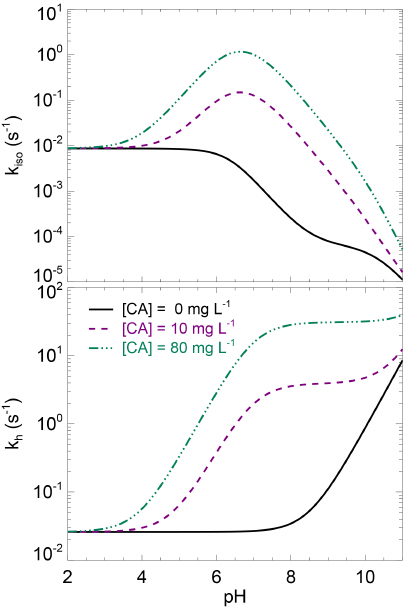
Figure 3. Theoretical rates of CO 2 hydration ( k h ) and CO 2 – H 2 O oxygen isotope exchange ( k iso ) as a function of pH, for three levels of carbonic anhydrase concentration. These theoreti- cal curves have been obtained using the un-catalysed rate formula compiled in Uchikawa and Zeebe (2012) and enzymatic parameters of k cat /K M = 70s − 1 µM − 1 and pK a = 7, which are typical values for CA-catalysed CO 2 hydration (Rowlett et al., 2002; Smith and Ferry, 2000). Using enzymatic parameter values more specific to the α -CA powder used here for the CA treatment (i.e. k cat /K M = 30 ± 5s − 1 µM − 1 and pK a = 7 . 1 ± 0 . 5) would not change qualita- tively this figure.